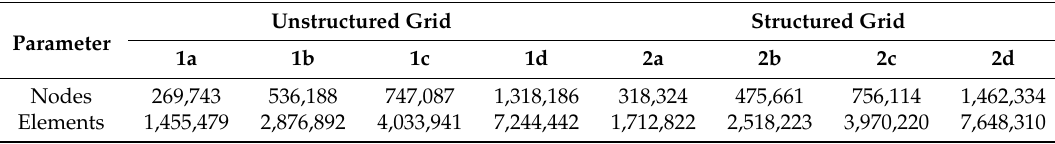
Table 4. Mesh sizing used for building model